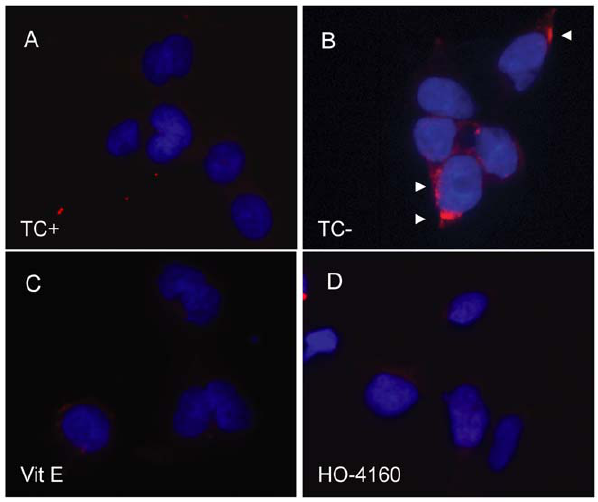
Figure 4. SLF blocks the appearance of oligomeric A b species within cultured cells. MC65 cells were treated with the indicated compounds (1 m M) immediately after the removal of the transgene suppressor tetracycline ( 2 TC; panels B–D) to induce A b O accumulation. At 24 hours, cells were fixed, immunofluorescently stained with the oligomer-specific antibody A11 (red) and counterstained with the nuclear dye DAPI (blue). As shown in panel (D), the cytoprotective SLF HO-4160, as well as the antioxidant vitamin E (Vit E) attenuate the accumulation of intracellular A b O (red fluorescent puncta).